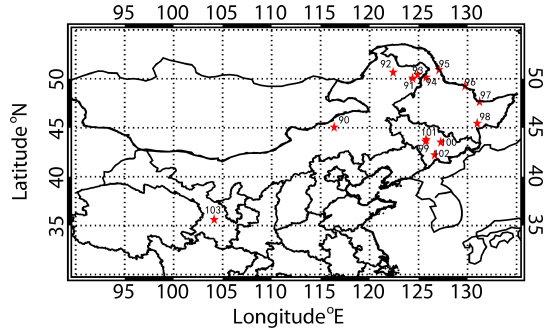
Figure 1. Sampling locations. Sites 90–102 are located in northeast China and were used for snow sample collection during January– February 2014. Snow sampling site 103 is located in Lanzhou in northwest China and was used for atmospheric sample collection during 5–25 August 2015. Sites are numbered according to Wang et al. (2013) and Ye et al.